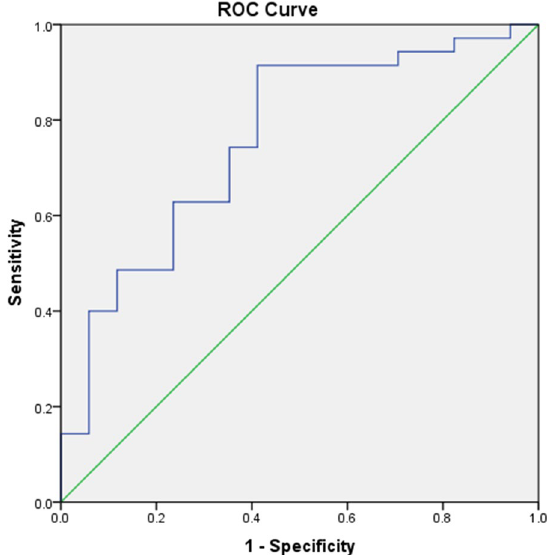
Fig. 2 Receiver operating characteristic curve for differentiation of Group 1 (Ishak stage 0–1-2–3) from Group 2 (Ishak stage 4–5–6). *Area Under Curve 0.905 (95% CI 0.814–0.996) ( p <